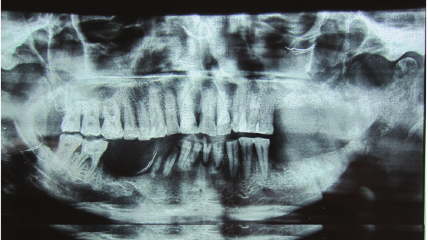
Figure 4: Follow-up OPG taken after 3 months revealed osteolysis extending to involve condyle.